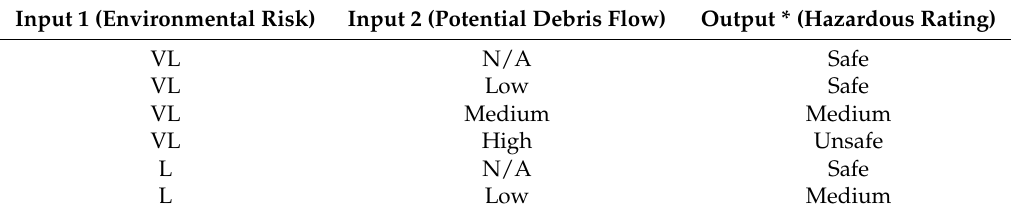
Table 6. Logic rules of fuzzy expert